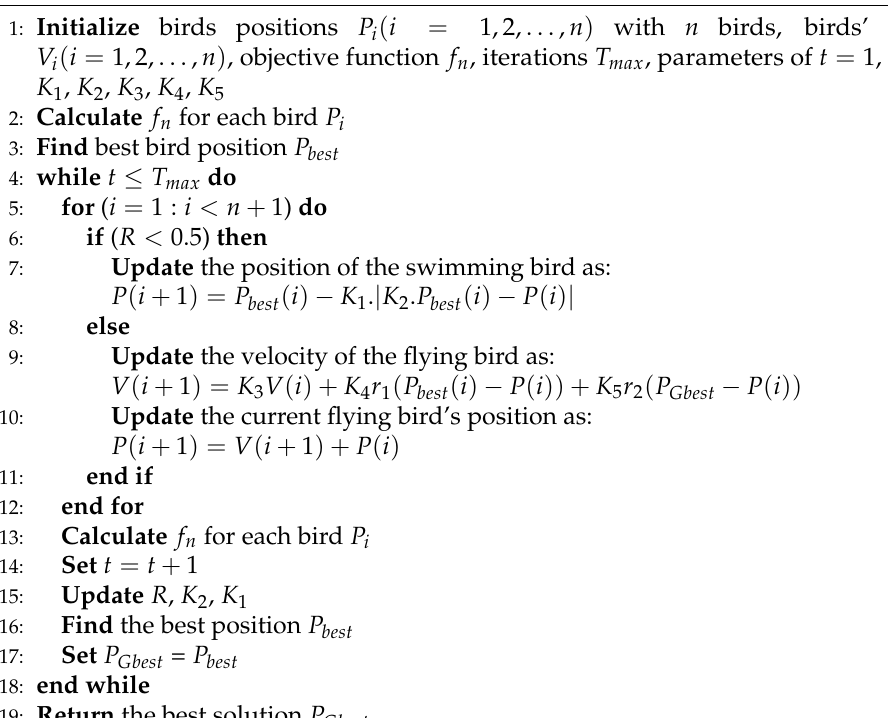
Algorithm 1 The dipper throated optimization (DTO)